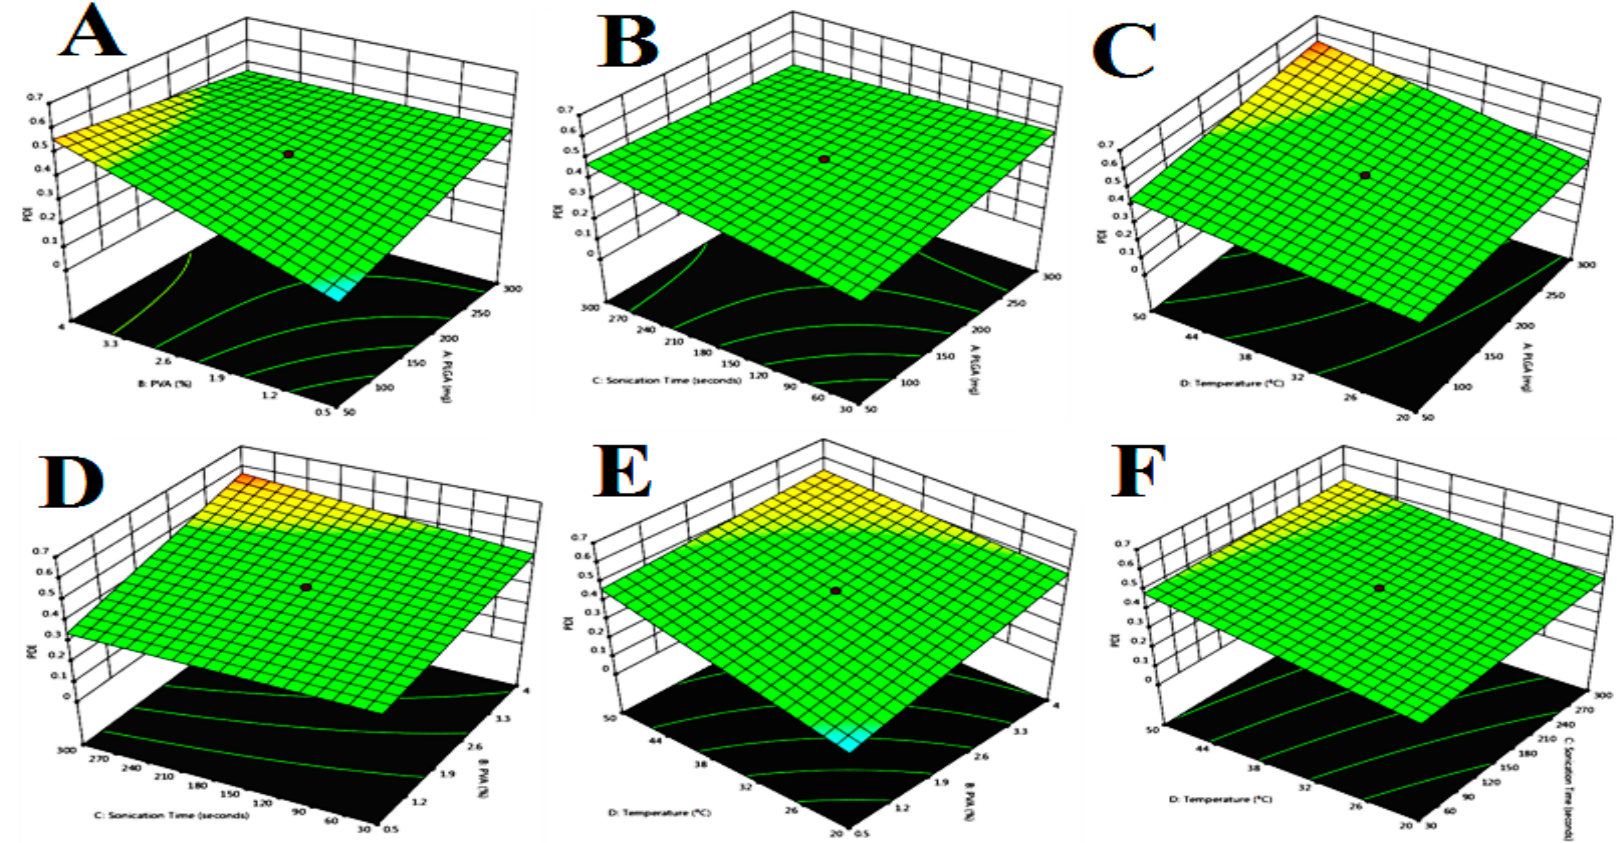
Figure 2. Response surface plot showing the effect of independent variables on polydispersity index (PDI), PLGA, PVA (%); ( A ). PDI, PLGA, sonication time; ( B ). PDI, PLGA, temperature; ( C ). PDI, PVA (%), sonication time; ( D ). PDI, PVA (%), temperature; ( E ). PDI, temperature, sonication time; ( F ). PDI, temperature, sonication time.